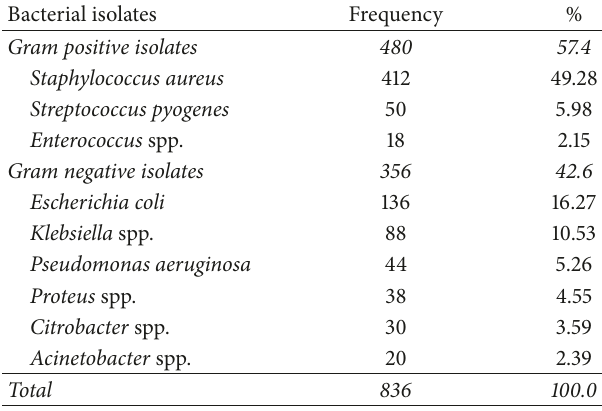
Table 1: Bacterial isolates associated with pyogenic wound infec-